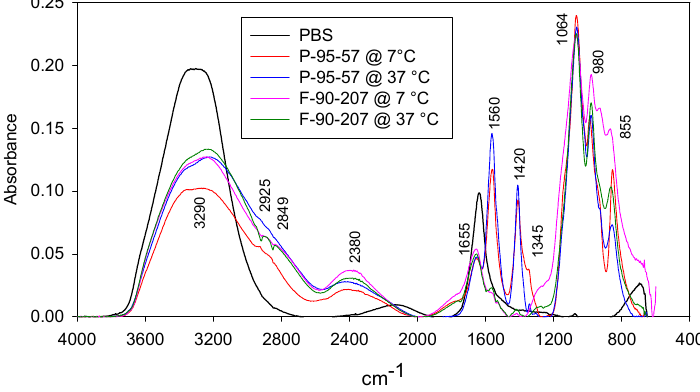
Figure 4. FTIR spectra: Peaks at 1345, 1420, 1560, 1655 and 3290 cm − 1 confirm the solubility of chitosan powder and flakes in the suspensions during the AB tests.